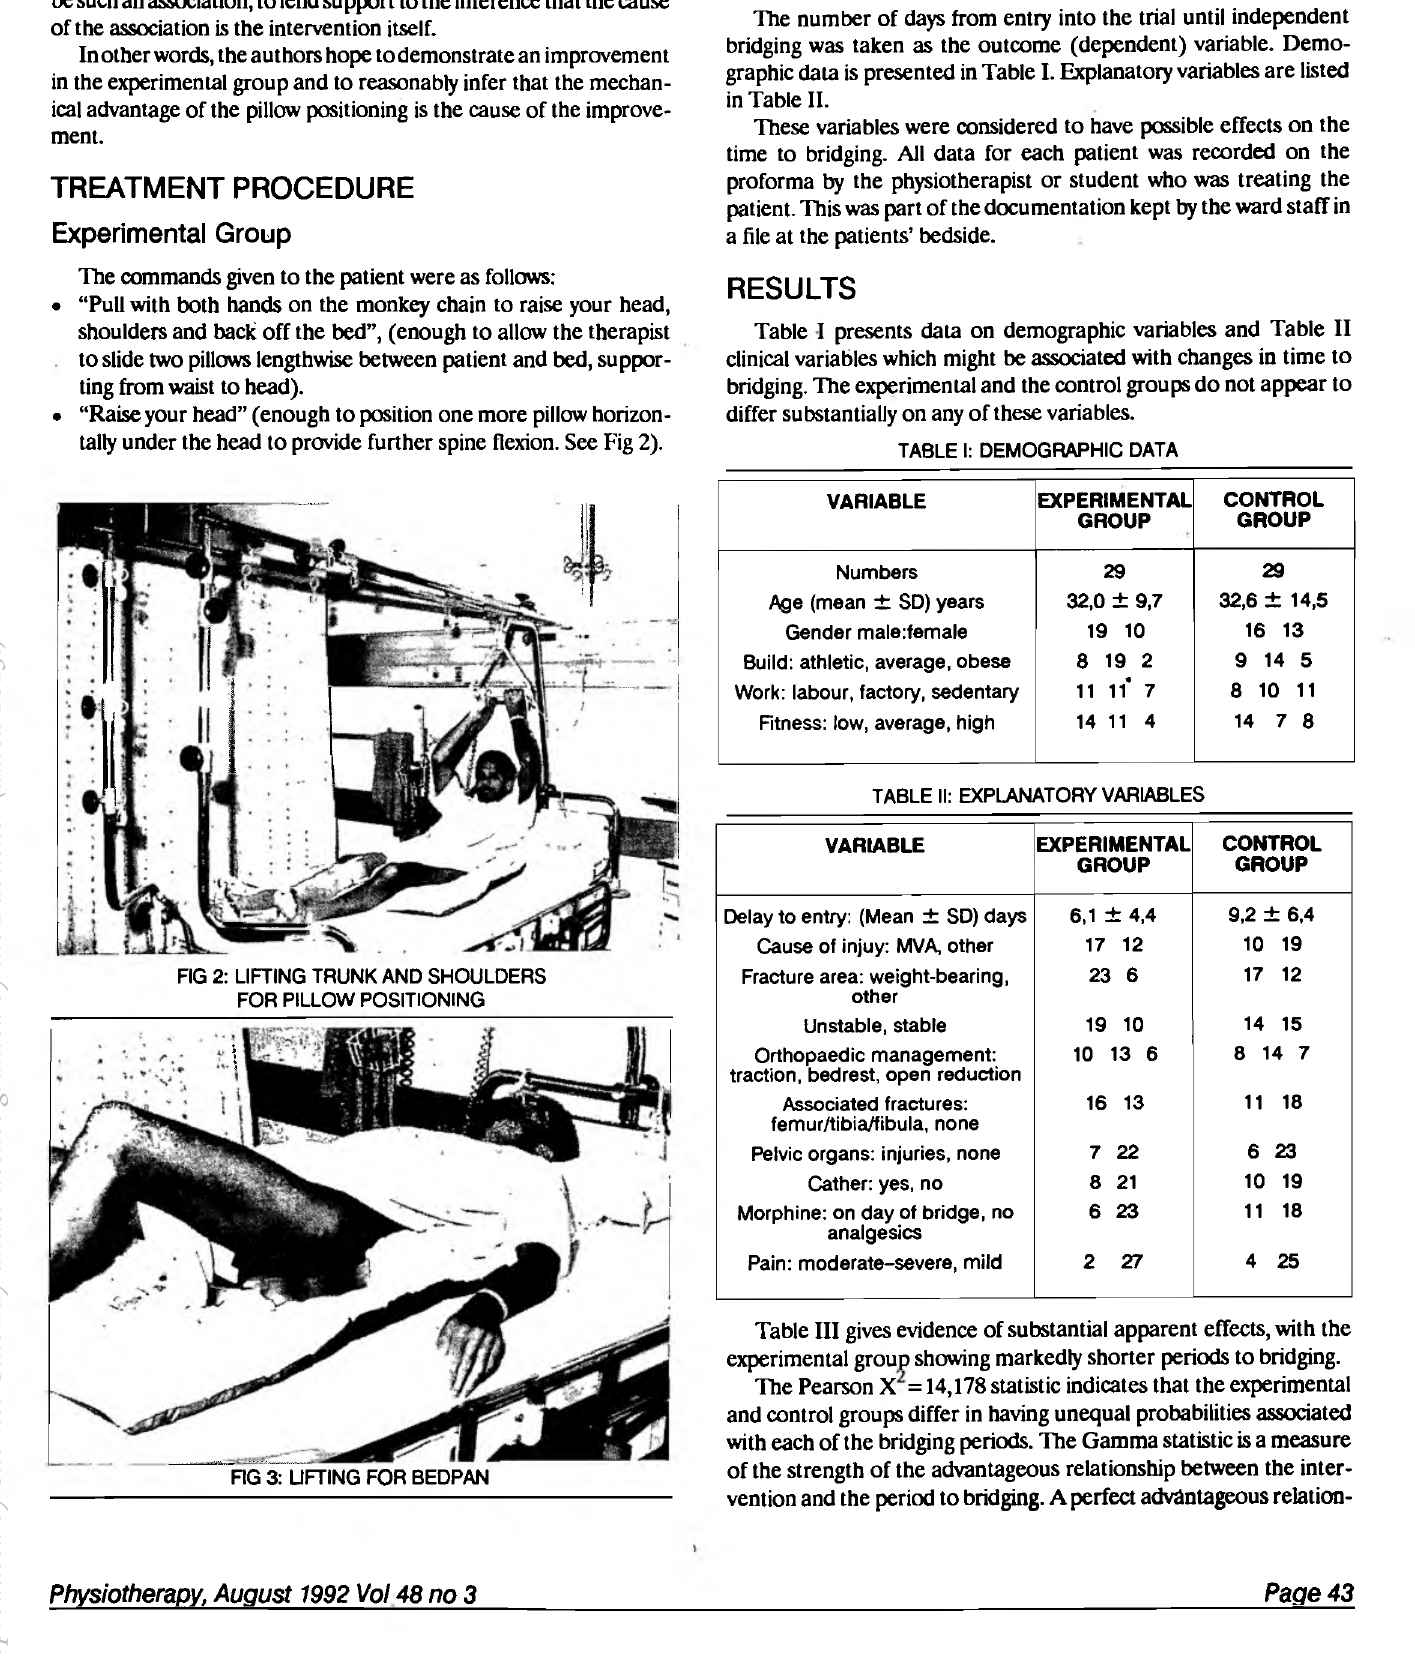
FIG 2: LIFTING TRUNK AND SHOULDERS FOR PILLOW POSITIONING